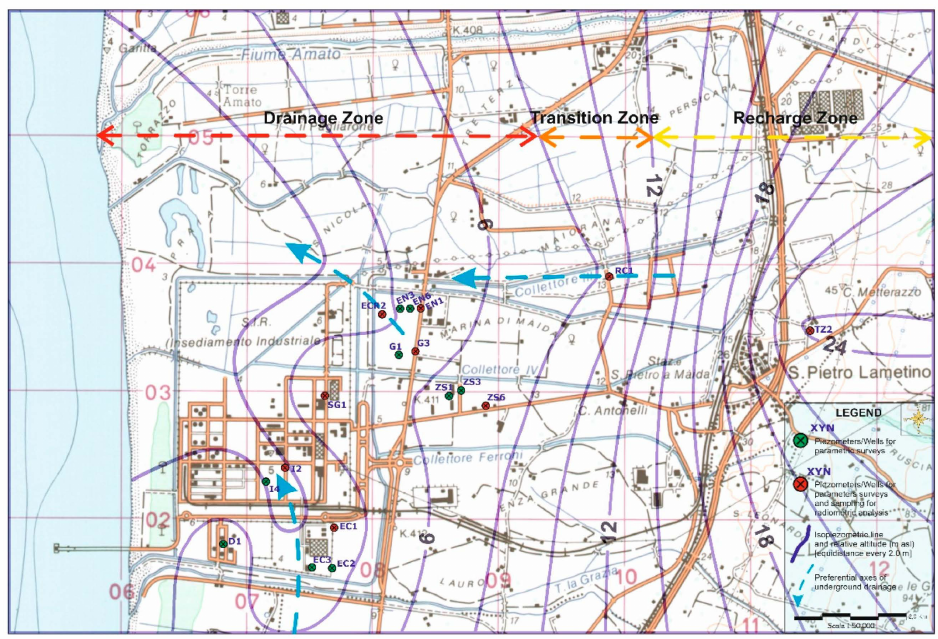
Figure 15. Groundwater Circulation Model Derived from the Piezometric Morphology (Modified From [6]).